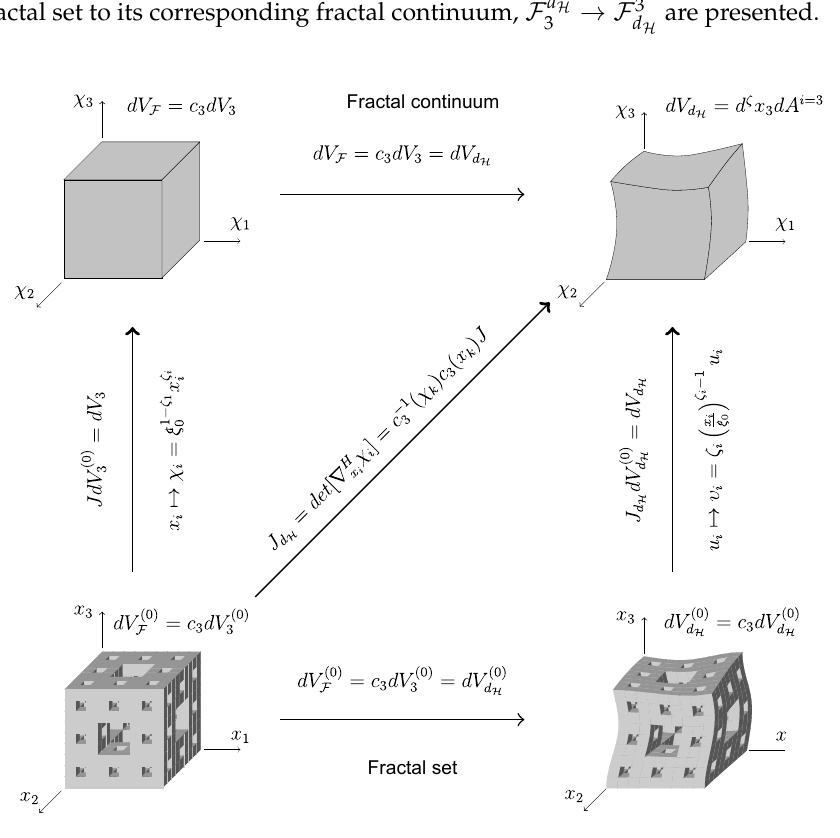
into the fractal continuum 3